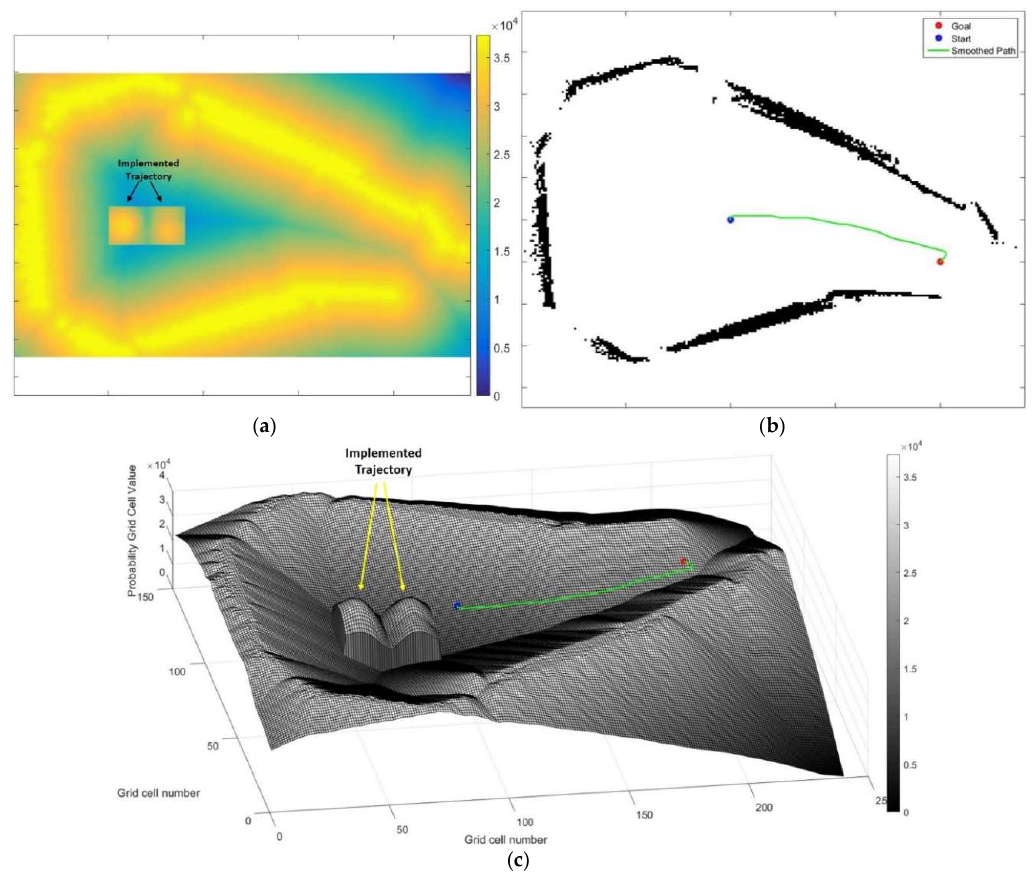
Figure 18. Adjusted A* algorithm in a static environment: ( a ) cost map; ( b ) 2D representation; and ( c ) 3D representation.